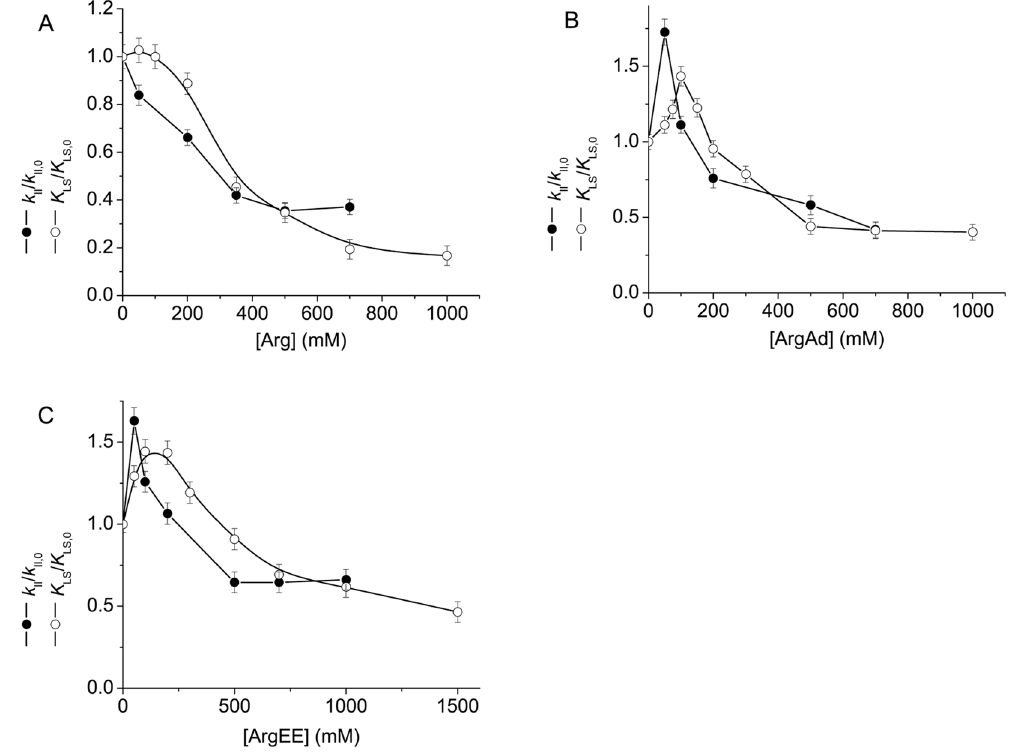
Figure 4. The dependences of the K LS / K LS,0 ratio and k II / k II,0 ratio on the concentration of Arg ( A ), ArgAd ( B ) and ArgEE ( C ). The error bars were calculated using three independent